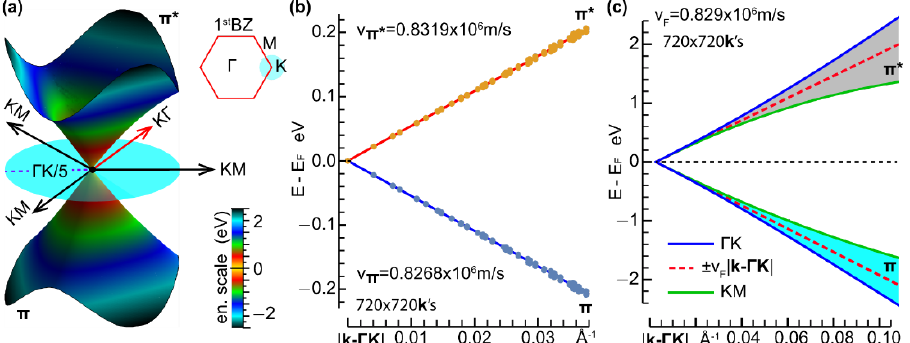
Figure 2. ( a ) Valence (π) and conduction (π*) energies of graphene around the K point, extracted from the 720 × 720 × 1 sampling of the 1st BZ, in our PW DFT-LDA approach. The Dirac cone approximation is reasonably accurate within ±0.8 eV, relative to the Fermi level, set to zero. ( b ) π and π* energies vs . the magnitude of the 2D crystal wave vector relative to the K point, for |𝐤 − 𝚪𝐊| < 0.04 Å −1 . The group velocities of the massless π* electrons and π holes, estimated by linear fitting, read v 𝜋∗ = 0.8319 × 10 6 m/s and v 𝜋 = 0.8268 × 10 6 m/s, respectively. ( c ) π and π* energies vs. for |𝐤 − 𝚪𝐊| < 0.10 Å −1 . The Fermi velocity value v F = 0.829 × 10 6 m/s, given by the arithmetic mean of v 𝜋∗ and v 𝜋 , provides an excellent approximation of the Dirac cone features.